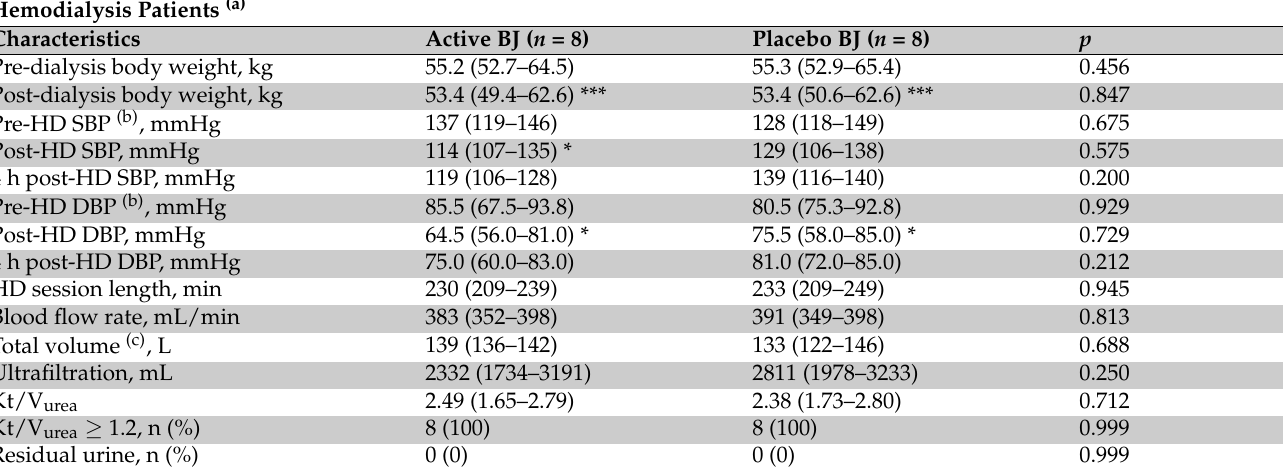
Table 2. Characteristics of hemodialysis patients before the ingestion of nitrate-rich (Active) and nitrate-depleted (Placebo) beetroot juice (BJ).